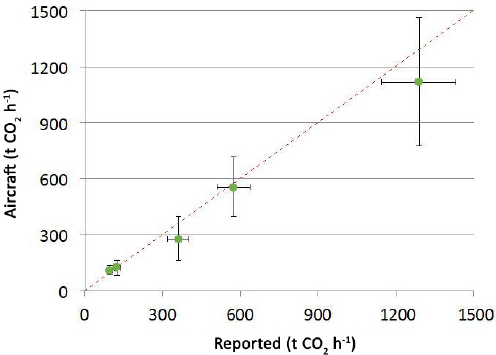
Figure 10. Comparison of aircraft vs. reported power plant emis-